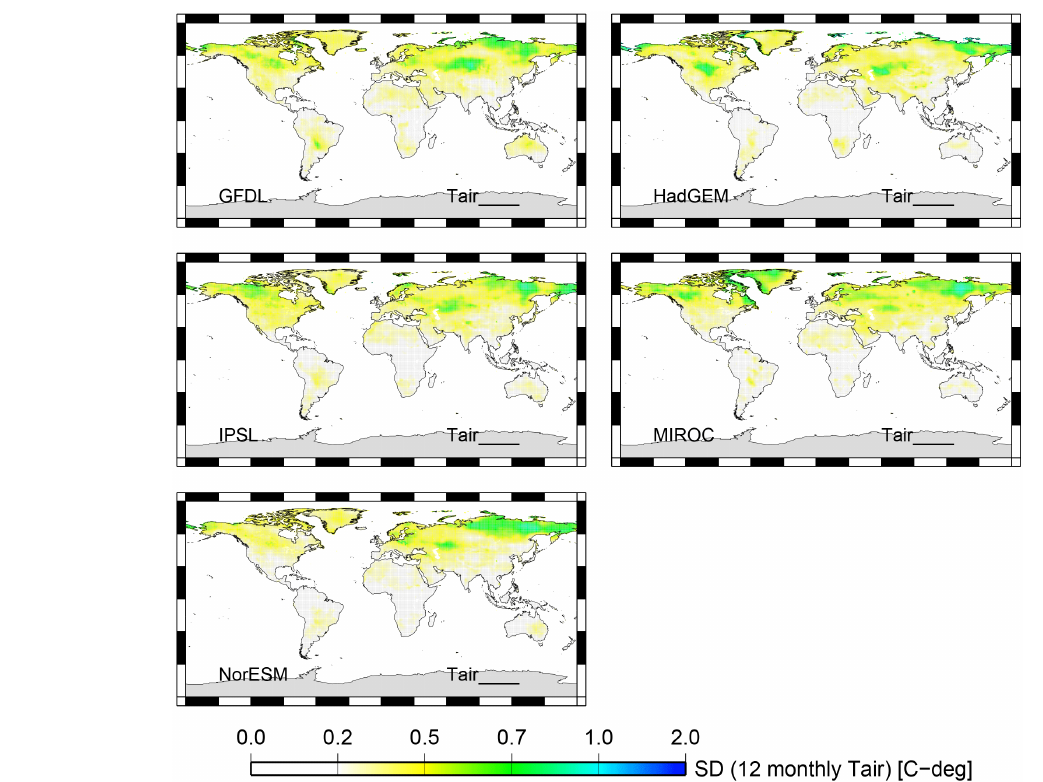
Figure 5. Same as Fig. 4 but for the atmospheric temperature. Table 4a. Results of the present (1971–2000) estimation and future (2070–2099) projection of irrigation water demand (IWD). The values in parentheses are changes (%) relative to the present values. The range (the difference between the maximum and minimum) of the five GCMs is given in the bottom